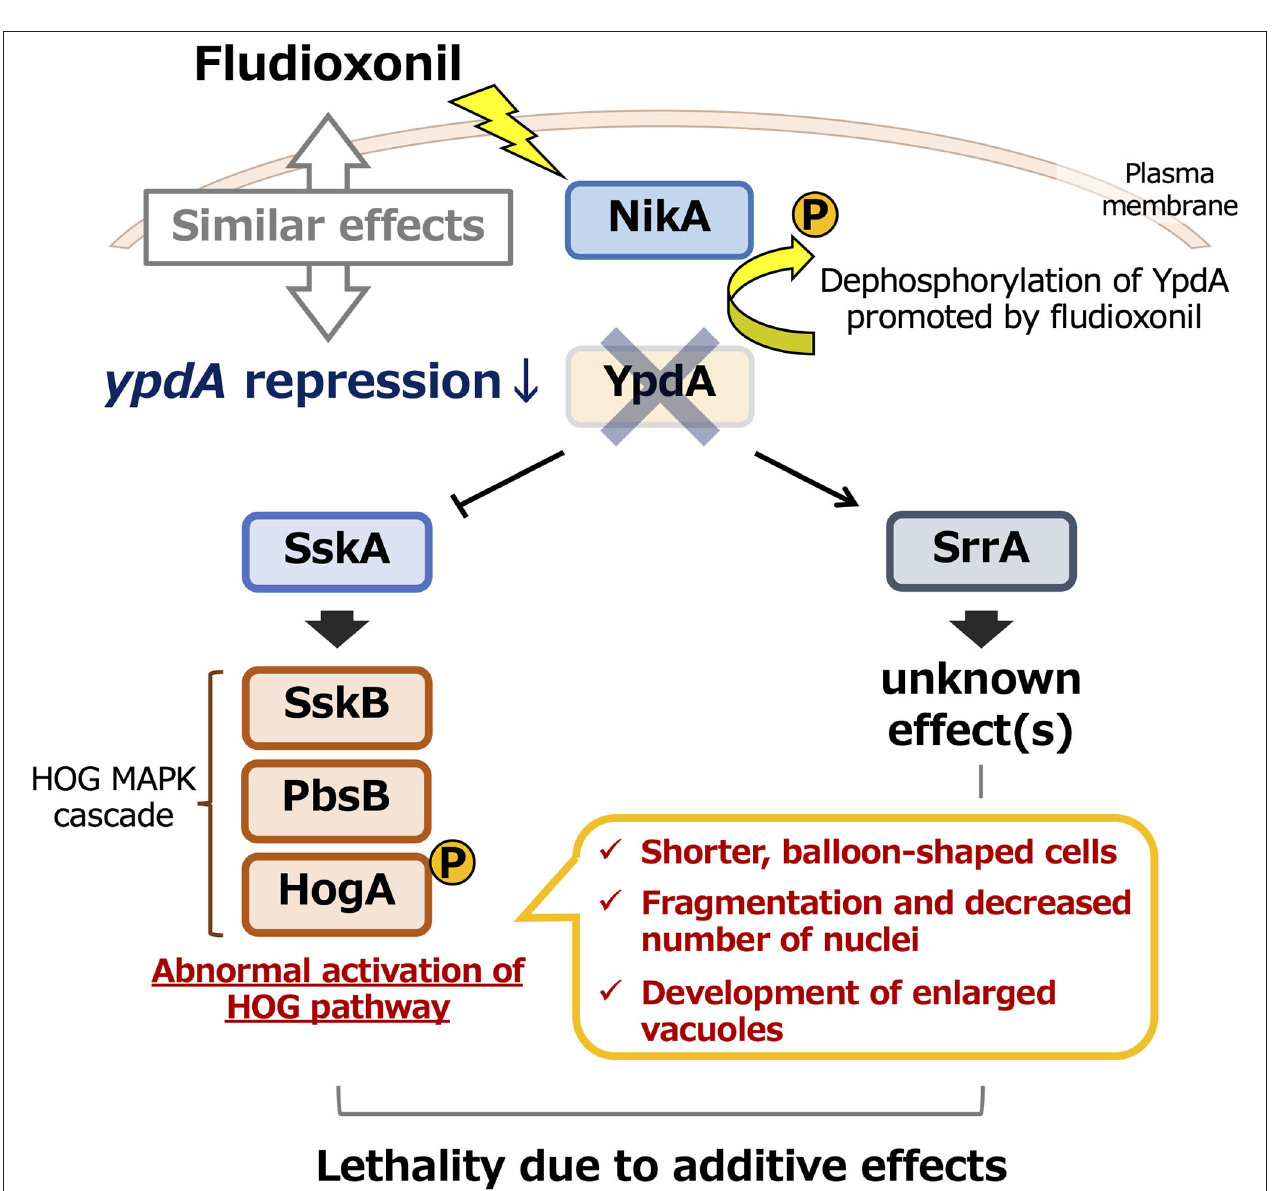
FIGURE 13 | Model of the effects of ypdA downregulation and fludioxonil treatment on two-component signaling in Aspergillus nidulans . Downregulation of ypdA and fludioxonil treatment have similar effects. Although morphological abnormalities depend only on the SskA pathway, the lethality caused by YpdA suppression or fludioxonil treatment depends on both the SskA and SrrA